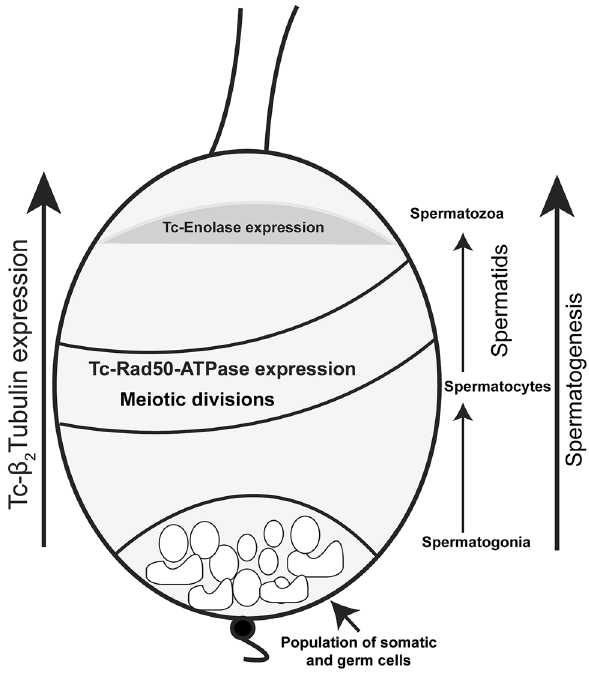
Figure 10. Diagram of the organization of a T. castaneum testis. The stem cell niche which is maintained by Stromal hub cells adheres to the apical tip of the testis. Hub cells are surrounded by germ line stem cells and somatic stem cells. Germ cells differentiate into spermatogonia and begin the development of spermatogenesis process to become mature sperm. Relative expression patterns of Tc-β2t , Tc-eno and Tc-rad50 are noted.